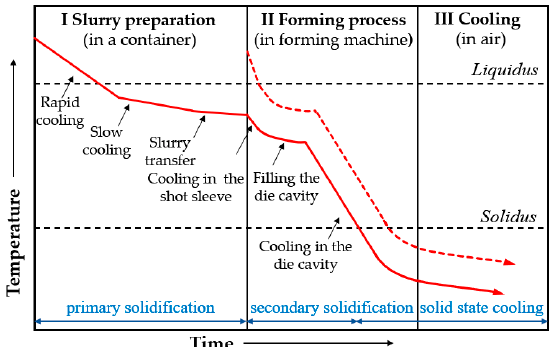
Figure 5. Typical solidification process of the rheo-HPDC (solid line) process and conventional HPDC process (dotted line).